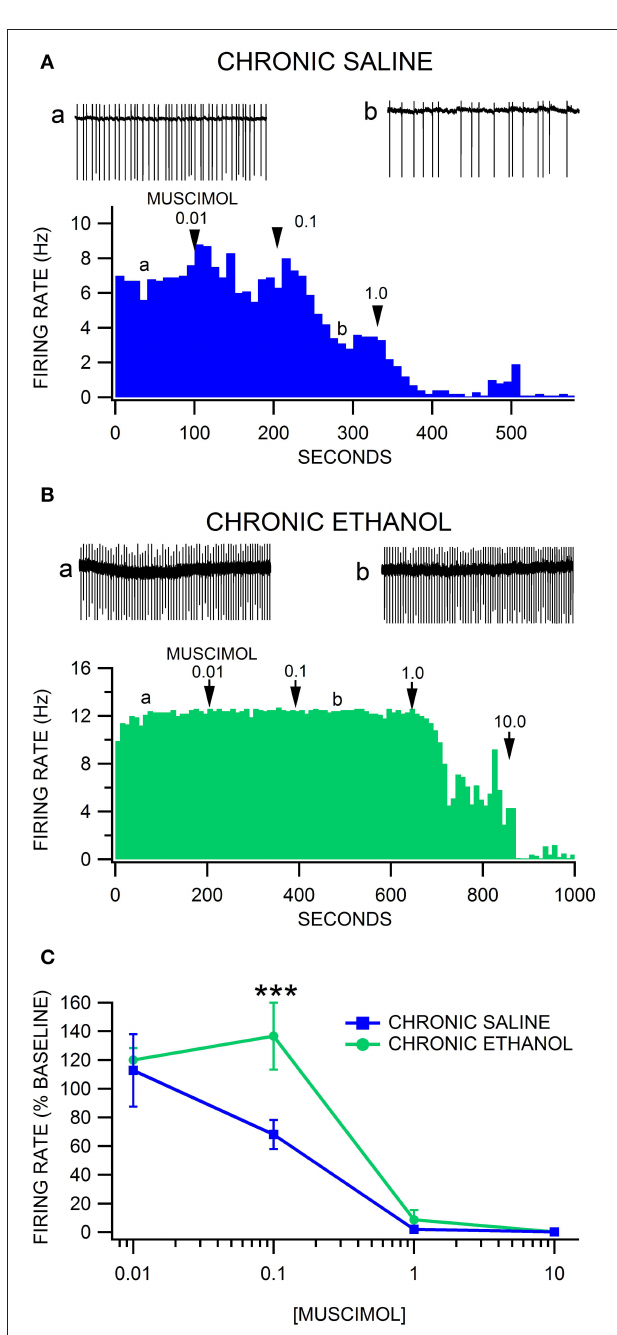
FIGURE 3 | Decreased sensitivity of VTA GABA neurons to muscimol after chronic ethanol injections. (A) The ratemeter shows the firing rate of a VTA GABA neuron (traces in a,b recorded at times indicated on graph) recorded in a brain slice from a mouse injected with saline twice-daily for 14 days. This representative neuron had a baseline firing rate of ∼ 7Hz. Muscimol markedly inhibited the firing rate of this VTA GABA neuron, with suppression of activity at the 1.0 µ M concentration. All insets are representative 5s traces of GABA neuron spike activity recorded before (inset a) and after (inset b) 0.1 µ M muscimol. (B) The ratemeter shows the firing rate of a GABA neuron in a mouse that was treated with 3.0 g/kg ethanol twice daily for 14 days. The baseline firing rate was ∼ 12Hz. This mouse was resistant to muscimol’s